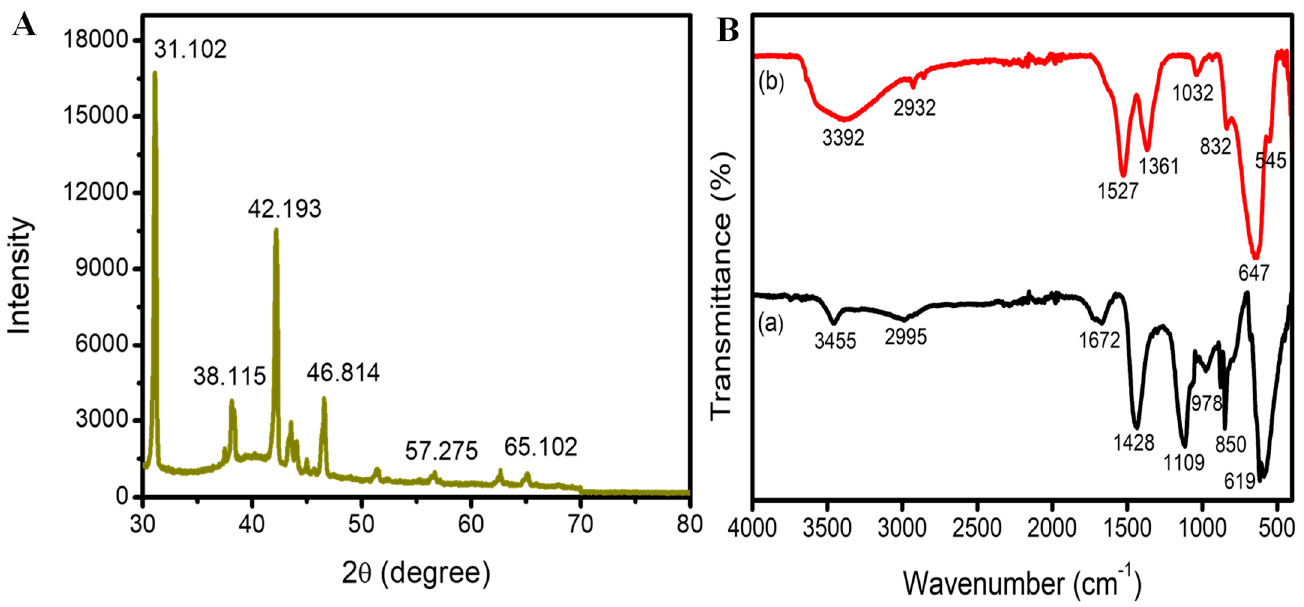
Figure 2. ( A ). FTIR spectrum of (a) Cassia auriculate flower extract alone and (b) Ca − AgNPs synthesized from Cassia auriculate. ( B ). XRD pattern of Ca − AgNPs synthesized from Cassia auriculate.